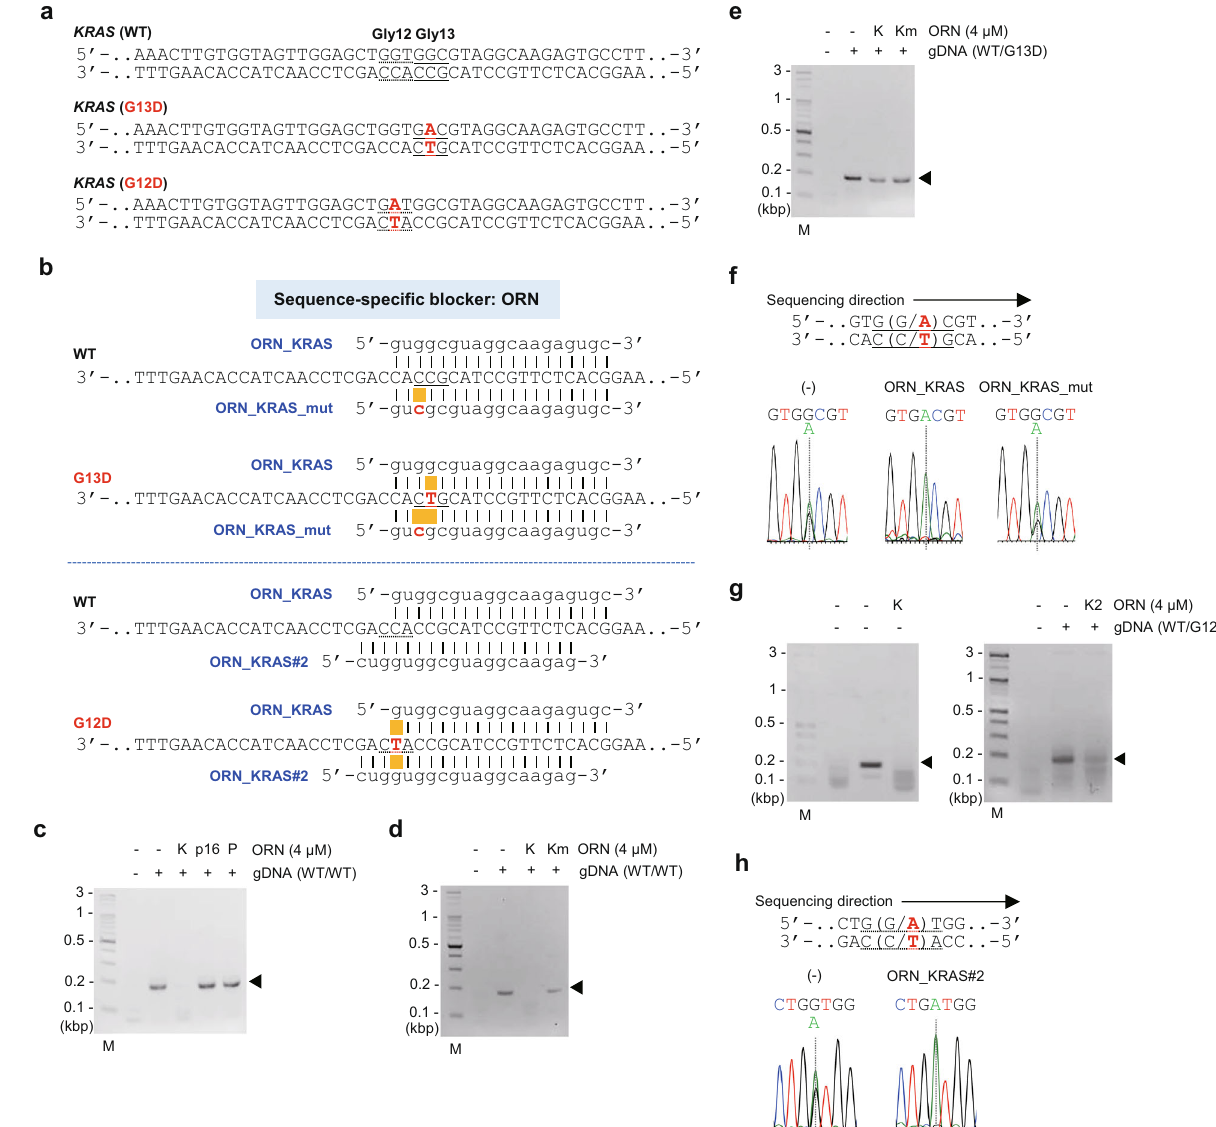
Fig. 2 Blocking RPA using ORNs as blocking agents. a The WT and mutated sequences of the human KRAS gene. b ORNs examined as sequence-speci fi c blocking agents and their complementary sequence in the human KRAS gene. c , d Results of RPA blocked by an ORN (ORNi-RPA) using template gDNA extracted from 293T cells, which are WT for KRAS . ORNs targeting human KRAS (ORN_KRAS; K), human CDKN2A (p16) (ORN_p16; p16), chicken Pax5 (ORN_cPax5_Ex1B; P), and an ORN that differs from ORN_KRAS by one nucleotide (ORN_KRAS_mut; Km) were used. Ampli fi ed KRAS is indicated by an arrowhead. M, molecular weight marker. e Results of ORNi-RPA of gDNA extracted from HCT116 cells, which have both a WT and mutant (G13D) allele of KRAS . f DNA sequencing analysis of ORNi-RPA products. RPA and ORNi-RPA products in e were puri fi ed and sequenced using a forward primer. g Results of ORNi-RPA of gDNA possessing both a WT and mutant (G12D) allele of KRAS . h DNA sequencing analysis of ORNi-RPA products. RPA and ORNi-RPA products in g were puri fi ed and sequenced using a forward Fig. 3a). We introduced mutations in the CDKN2A (p16) gene ampli fi cation of a region of gDNA containing 8 copies of LexA- in 293T cells and extracted gDNA for use in CRISPRi-RPA binding elements (LexA BE) 17 (Supplementary Fig. 8a – c), but not the irrelevant KRAS gene (Supplementary Fig. 8d), suggesting (Fig. 3h). Because the genome editing was highly ef fi cient (Sup- sequence-speci fi c suppression of the RPA reactions. Thus, DNA- plementary Fig. 7a and b), we mixed parental and genome-edited binding proteins can be used to suppress RPA reactions in a gDNA (4: 1) to mimic lowly ef fi cient genome editing (Fig. 3i). We sequence-speci fi c manner. found that CRISPRi-RPA ampli fi ed only the edited CDKN2A (p16) sequences (Fig. 3i and j), suggesting that CRISPRi-RPA is useful in the evaluation of genome editing events. Discrimination of CpG methylation status by blocking RPA using a methyl-CpG binding protein . Lastly, we examined Blocking RPA using a DNA-binding protein . Next, we exam- methyl-CpG binding domain protein 2 (MBD2) 18 , a methylated CpG-binding protein often used for methylated DNA enrich- ined DNA-binding proteins as sequence-speci fi c blockers of RPA. ment 19,20 , as a potential epigenetic mark-speci fi c blocker of RPA LexA, a bacterial DNA-binding protein, strongly suppressed